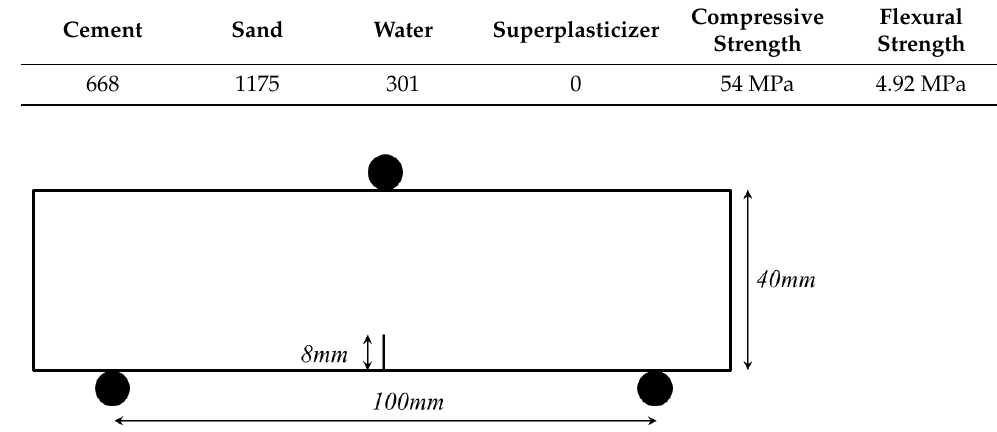
Figure 11. Specimen geometry and boundary condition for the notched mortar beam.